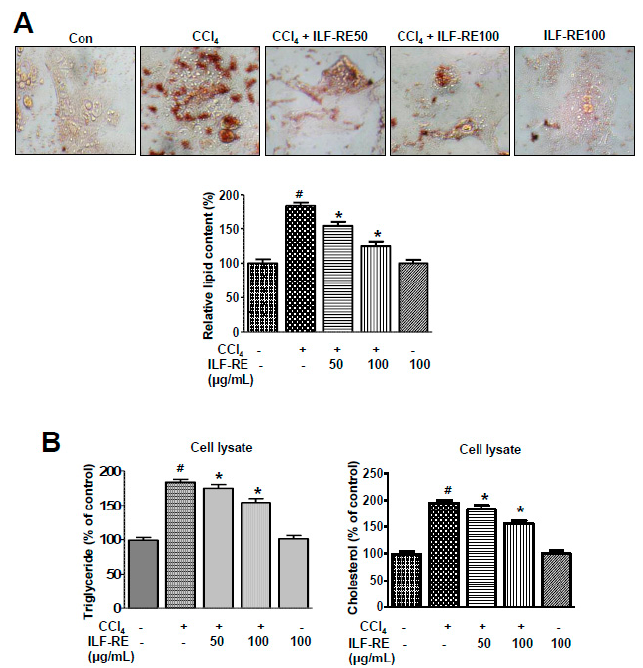
Figure 6. ILF-RE reduced hepatic lipid accumulation. ( A ) Primary hepatocytes were treated with 20 mM CCl 4 in the absence or presence of 50 and 100 µ g/mL ILF-RE for 6 h. Lipid accumulation was assessed via Oil Red O staining. Images of cells were obtained at 200 × magnification and used for quantitative analysis of cellular lipid deposition. ( B ) Cells were treated with 50 and 100 µ g/mL ILF-RE in the absence or presence of 50 and 100 µ g/mL ILF-RE for 6 h. Triglyceride and cholesterol levels were measured in cell lysates. Data are expressed relative to the controls ( n = 3; # p < 0.05 vs. Con; * p < 0.05 vs. CCl 4 ). Con, control; CCl 4 , carbon tetrachloride; ILF-RE, the combination R. verniciflua with E.